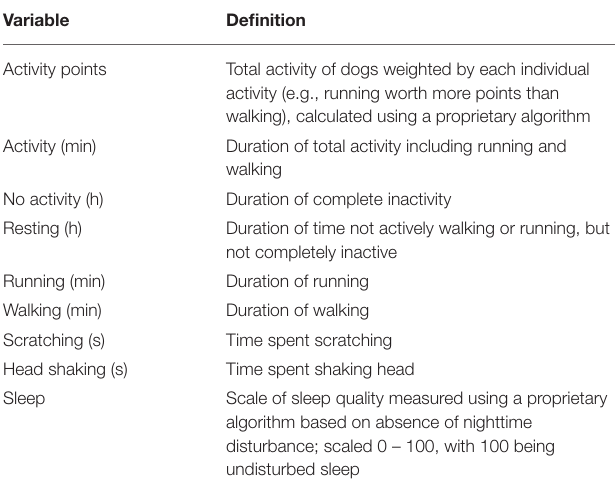
TABLE 2 | Activity variables measured by Vetrax ® activity sensors (AgLogica Holdings, Inc., Norcross, GA).